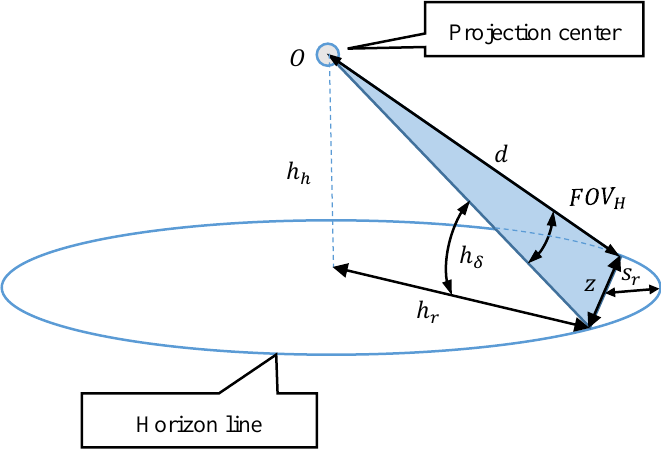
Figure 4. Part of the horizon line (with the length z ) in the FOV H of the camera.